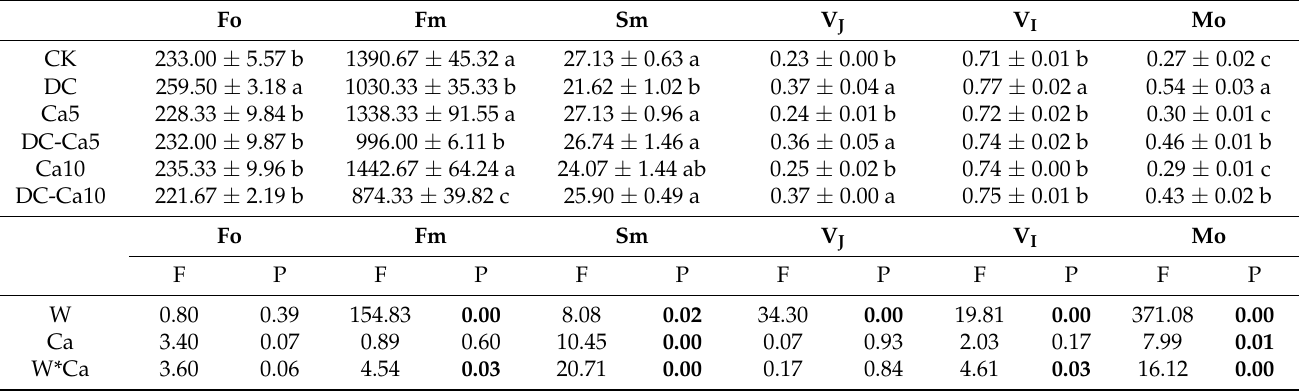
Different letters within a single column indicate significant differences at p < 0.05 determined by Duncan’s multirange test. F and P values are provided for the effects of the main variables water (W), calcium (Ca), and their interactions (W*Ca). p < 0.05 are shown by bold letters.